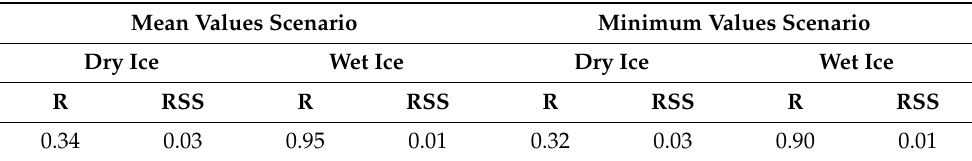
Figure 11. A comparison between COFs obtained from the mechanical method at KITE and the human-centred MAA method for ( a ) Mean values scenario on dry ice, ( b ) Minimum values scenario on dry ice, ( c ) Mean values scenario on wet ice, and ( d ) Minimum values scenario on wet ice. The solid black line represents what would be a perfect agreement where MAA_COF mean = KITE_COF mean and MAA_COF min = KITE_COF min . The black dash lines represent the set threshold of 0.12. The red zone represents the area where the mechanical method incorrectly classifies the footwear as one snowflake footwear, while the MAA method ranked footwear in that zone as unsafe footwear for icy surfaces. Table 4. Residual Sum of Squares (RSS) with respect to the line (y = x) and correlation coefficient ‘R’ between KITE_COF and MAA_COF on two different